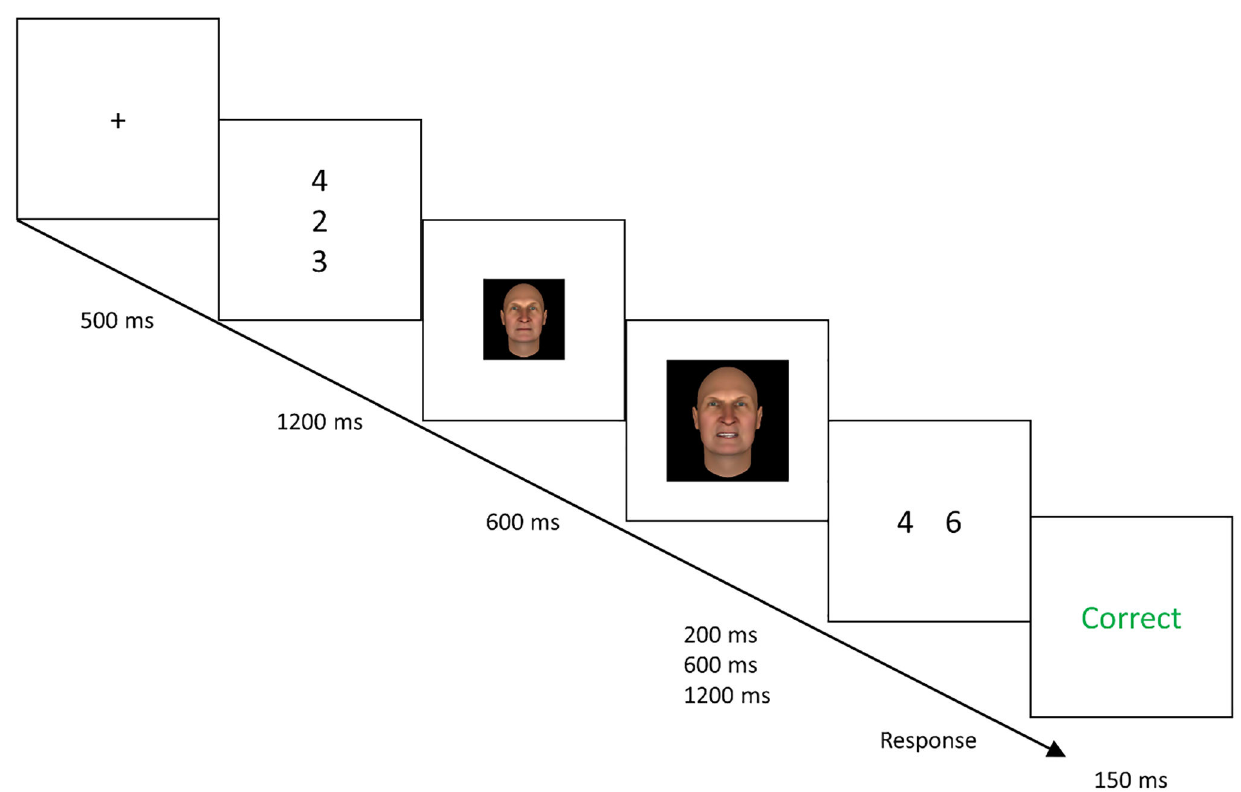
Figure 1. Illustration of the task. Note. Illustration of the Virtual Attack Emotional Sternberg Task. Trials consisted of a fixation cross, presentation of the memory set, maintenance period, and probe stimulus. The Figure shows an Attack trial, in which the first 600 ms of the maintenance period contained a neutral face. At 600 ms, the face’s expression turned angry and the face “jumped out at” the participant by increasing in size, suggesting approach. 200, 600 or 1200 ms following the attack, the probe stimulus was presented. The probe remained onscreen until a left-key or right-key response was given, indicating which of the numbers was in the current memory set. Correct answers were followed by a feedback screen briefly showing “Correct” in green, and incorrect answers were followed by “Incorrect” in red. On Neutral Face trials, the attack did not occur and the neutral face remained onscreen until the probe. On such trials, the face remained onscreen for the initial 600 ms plus the varying 200, 600, or 1200 ms. On Null trials, no face appeared, and only a fixation cross was shown during the maintenance